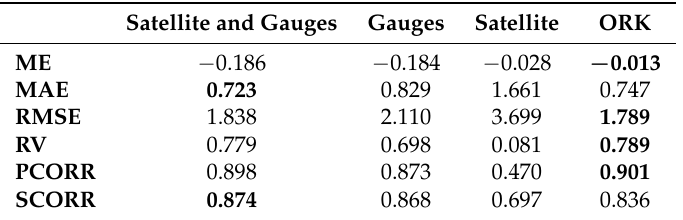
Table 10. Daily precipitation regression scores averaged on the climatological test gauges, for the test days. The ME, the MAE and the RMSE are expressed in mm.